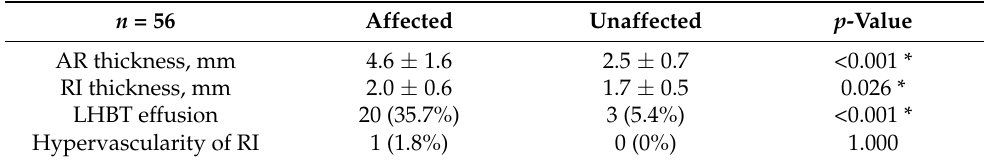
Table 2. Ultrasound parameters between affected and unaffected shoulders at baseline